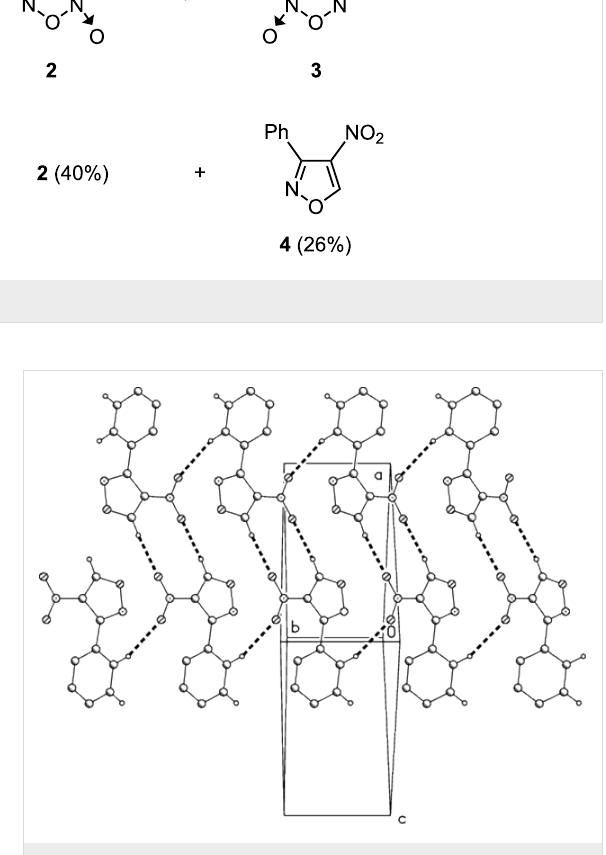
Figure 2: Packing diagram of compound 4 viewed perpendicular to (101). Hydrogen bonds are indicated by thick dashed